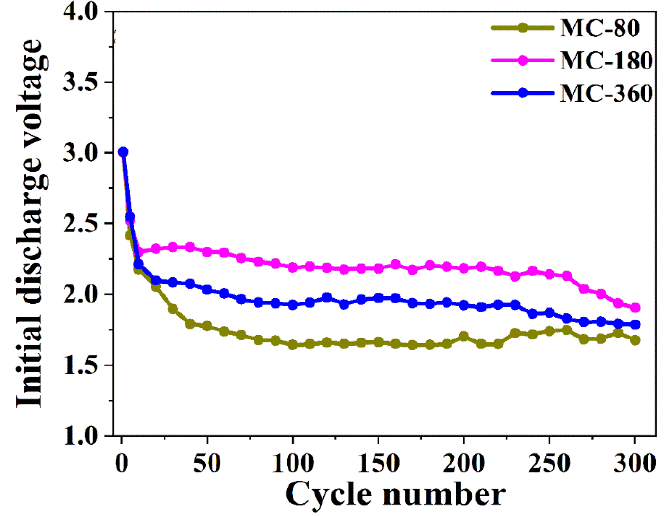
Figure 11. The initial discharge voltage at every cycle of MC-80, MC-180, and MC-360.